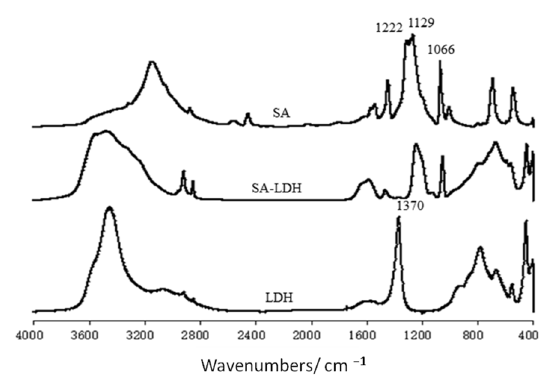
Figure 1. FT-IR spectra of LDH, SA-LDH, and NH 2 SO 3 H.